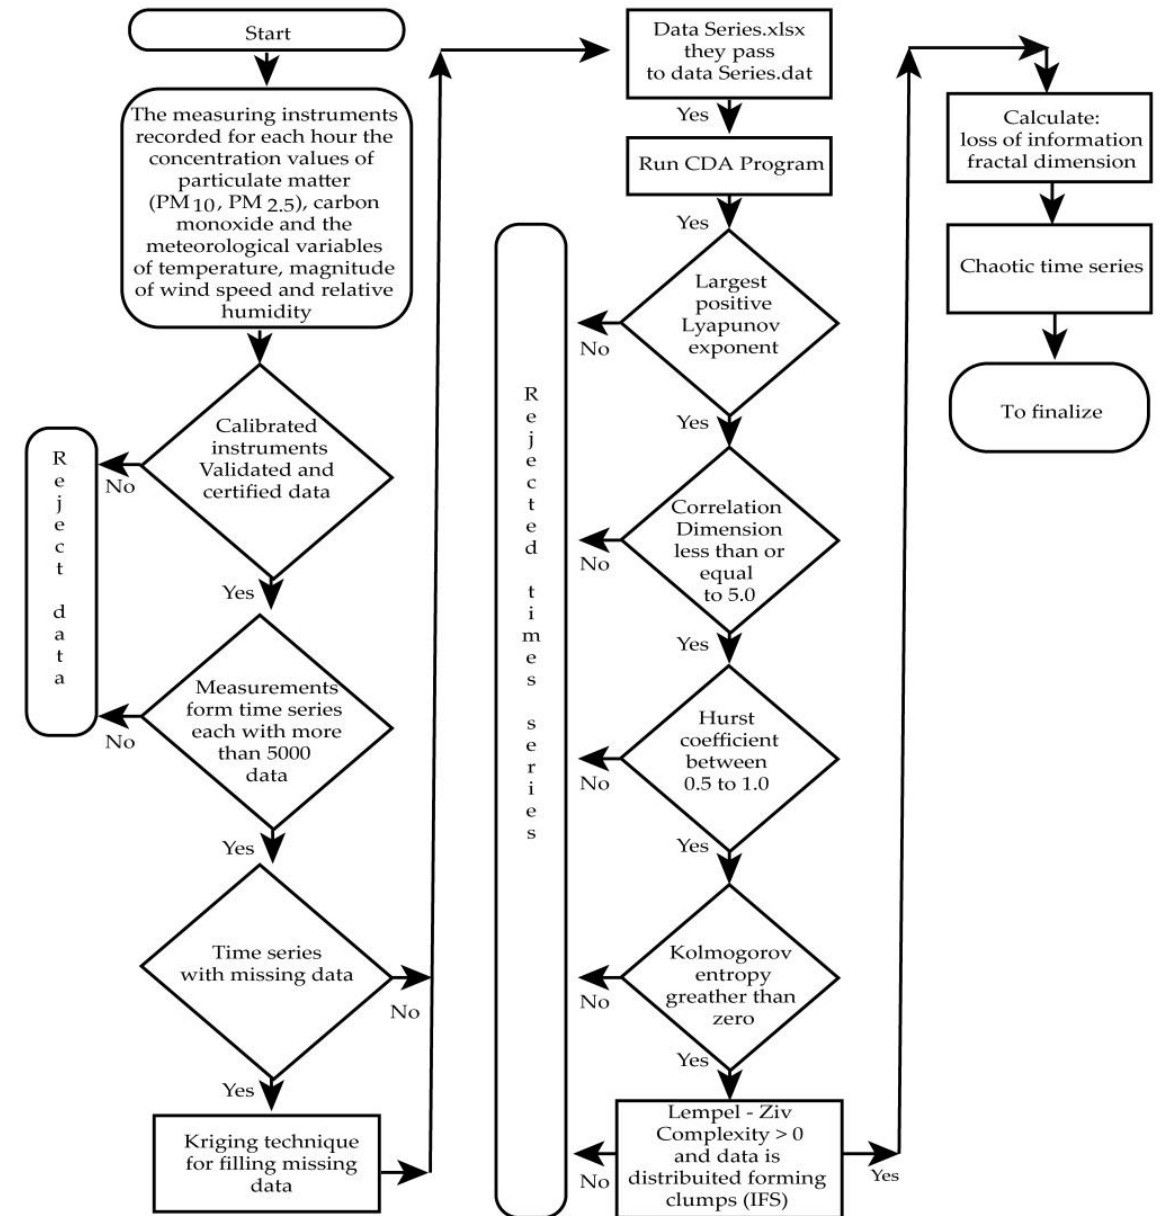
Figure 4. Flowchart that allows to verify if each time series is chaotic and calculates the chaotic parameters of interest (Lyapunov exponent, correlation dimension, entropy, Hurst exponent, Lempel-Ziv complexity, fractal dimension and loss of information).